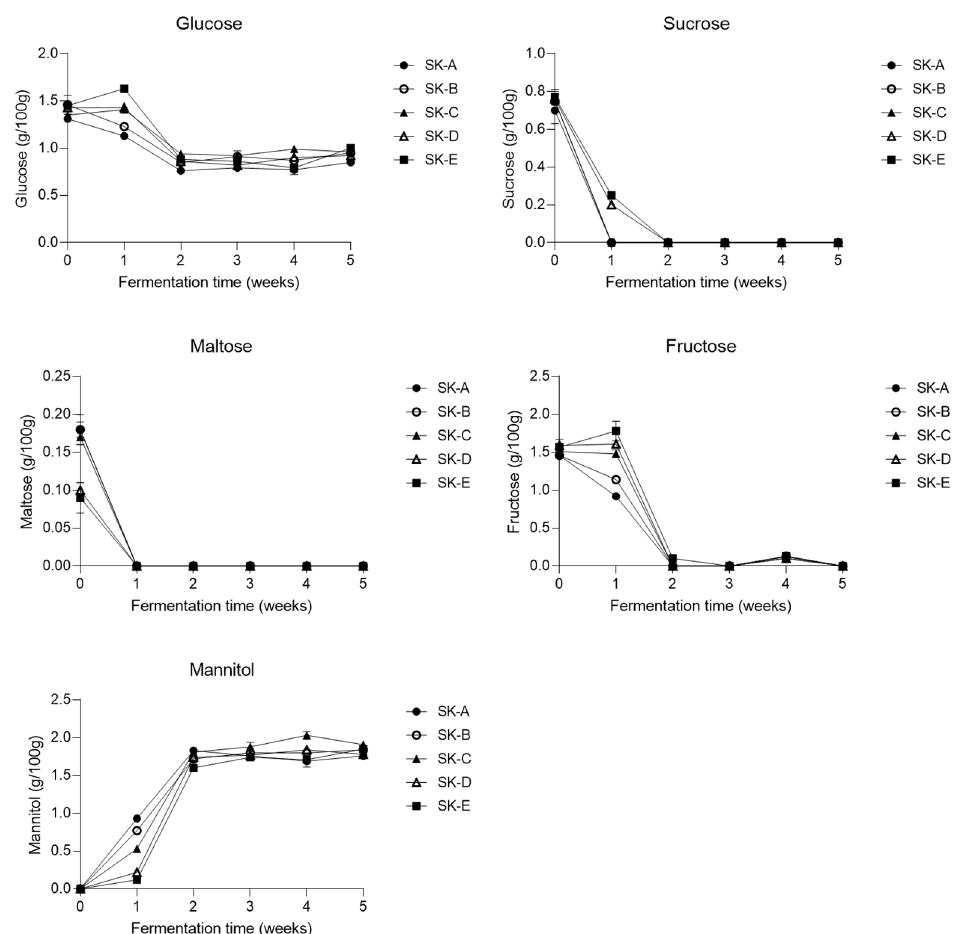
Figure 4. Changes in the free sugar contents of kimchi samples with different salinities during fer- mentation.